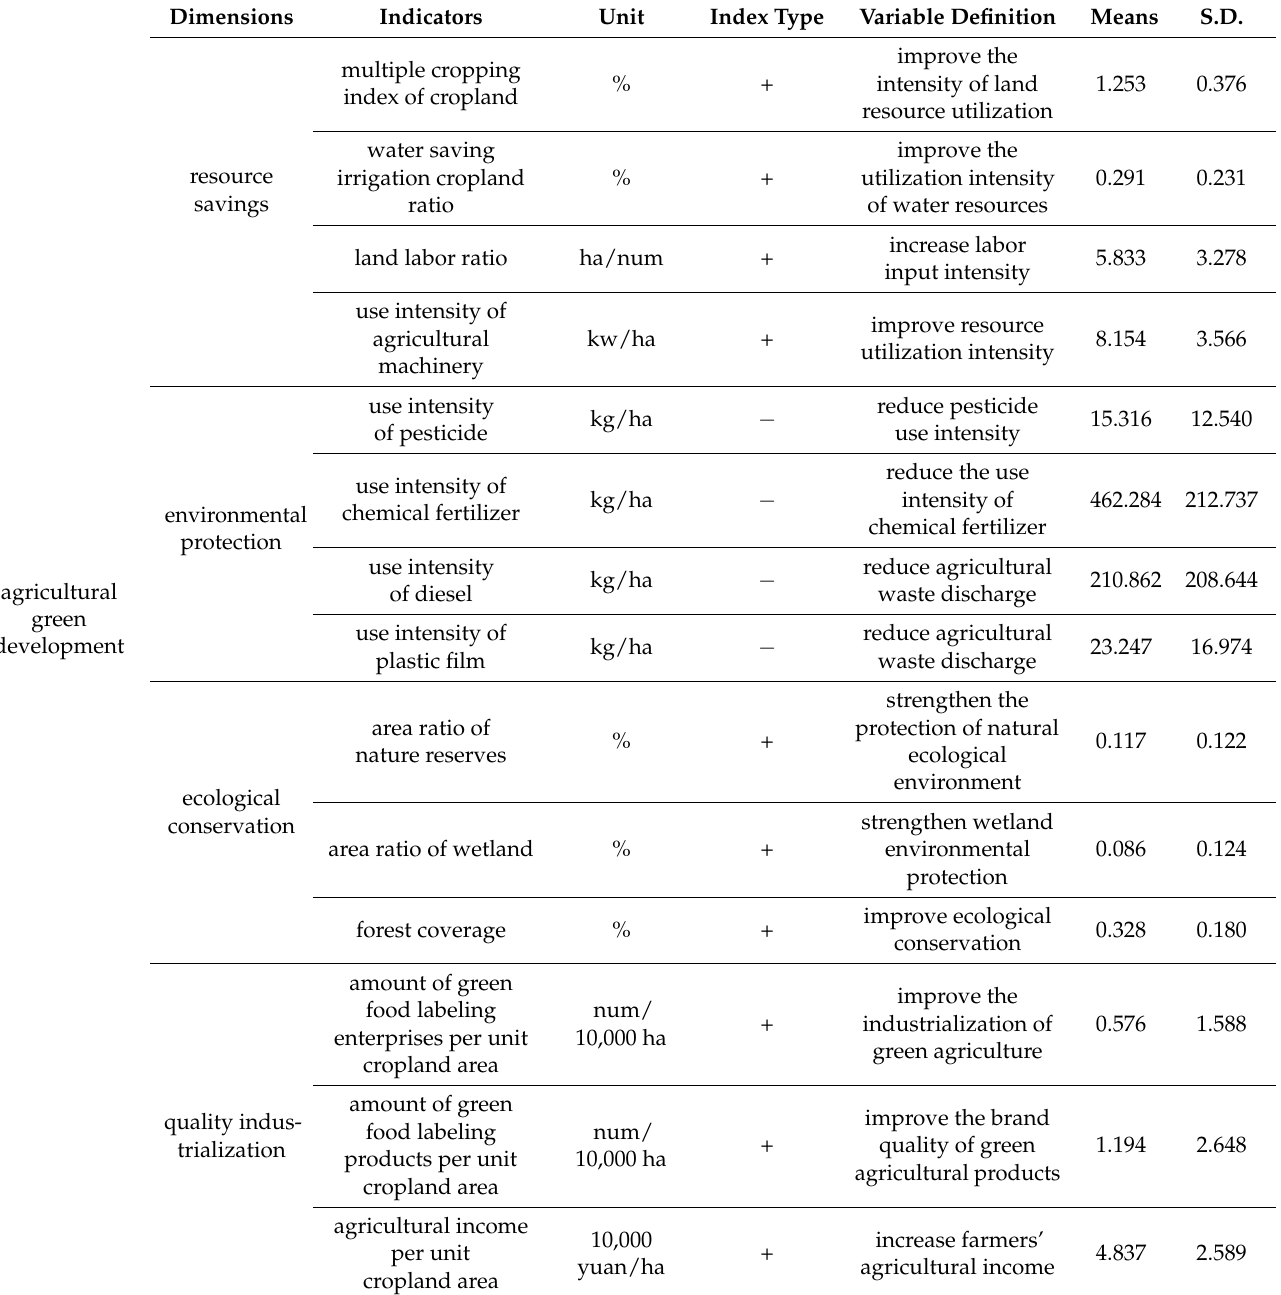
Table 1. The system of the agricultural green development